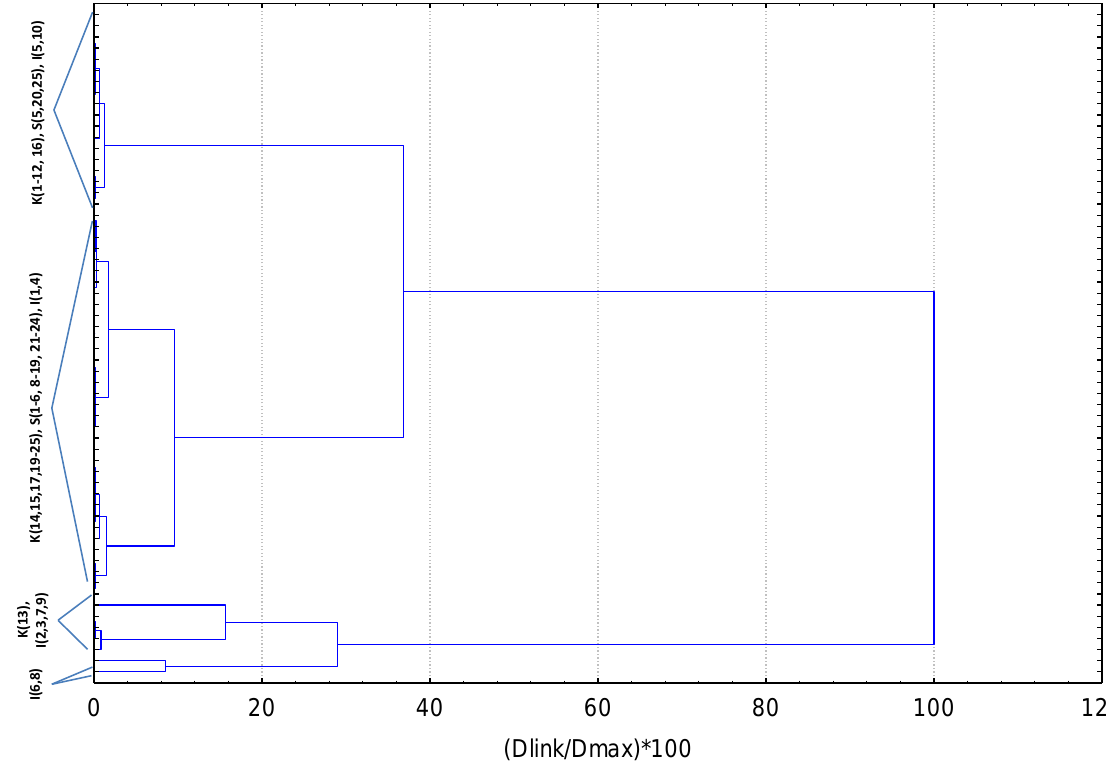
Figure 3. Dendrogram for hierarchical cluster analysis of five metals concentrations in sediments collected from 60 sites in three neighboring gulfs of North Aegean Sea, Greece. Dlink / Dmax represents the quotient of the linkage for a particular sampling site divided by the maximum distance; the quotient is multiplied by 100 for standardizing the linkage distance on the y